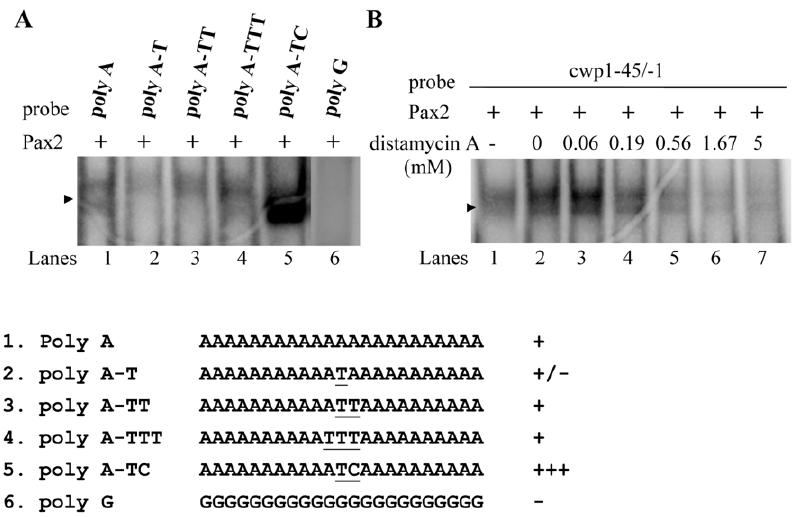
Figure 7. Analysis of Pax2 binding ability. (A) Pax2 may bind to AT-rich sequence. Electrophoretic mobility shift assays were performed using purified Pax2 and various 32 P-end-lableled oligonucleotide probes as described. Components in the binding reaction mixtures are indicated above the lanes. The arrowhead indicates the shifted complex. ‘‘ + ’’, ‘‘ + / 2 ’’, and ‘‘ 2 ’’ represent moderate binding, weak binding, and no binding, respectively. ‘‘ +++ ’’ and ‘‘ ++ ’’ represent strong binding. (B) Effect of distamycin A on the binding of Pax2 to DNA. 32 P end-labeled cwp1-45/ 2 1 probe was incubated with Pax2 in the absence (lane 1) or presence of distamycin A (lanes 3–7). The arrowhead indicates the shifted complex. DistamycinA was dissolved in Me2SO. Adding Me2SO to the reaction mix did not decrease the Pax2 binding activity (lane 2).